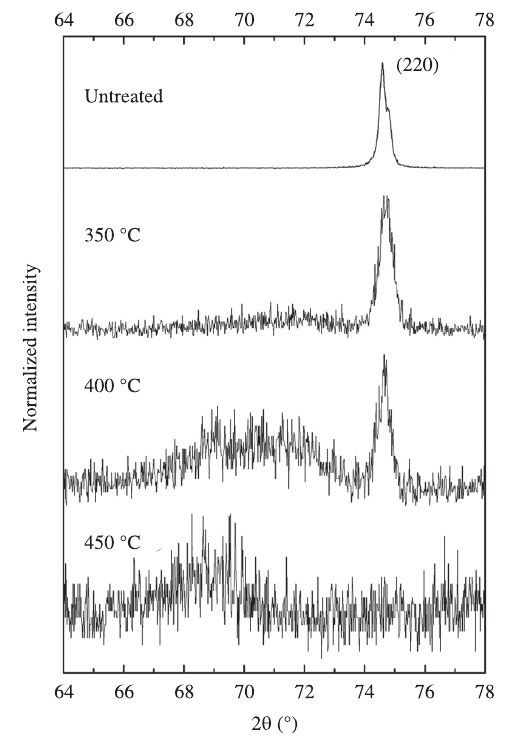
Figure 6. Zoom of the (220) reflection of samples nitrided for 3h, at different temperatures.